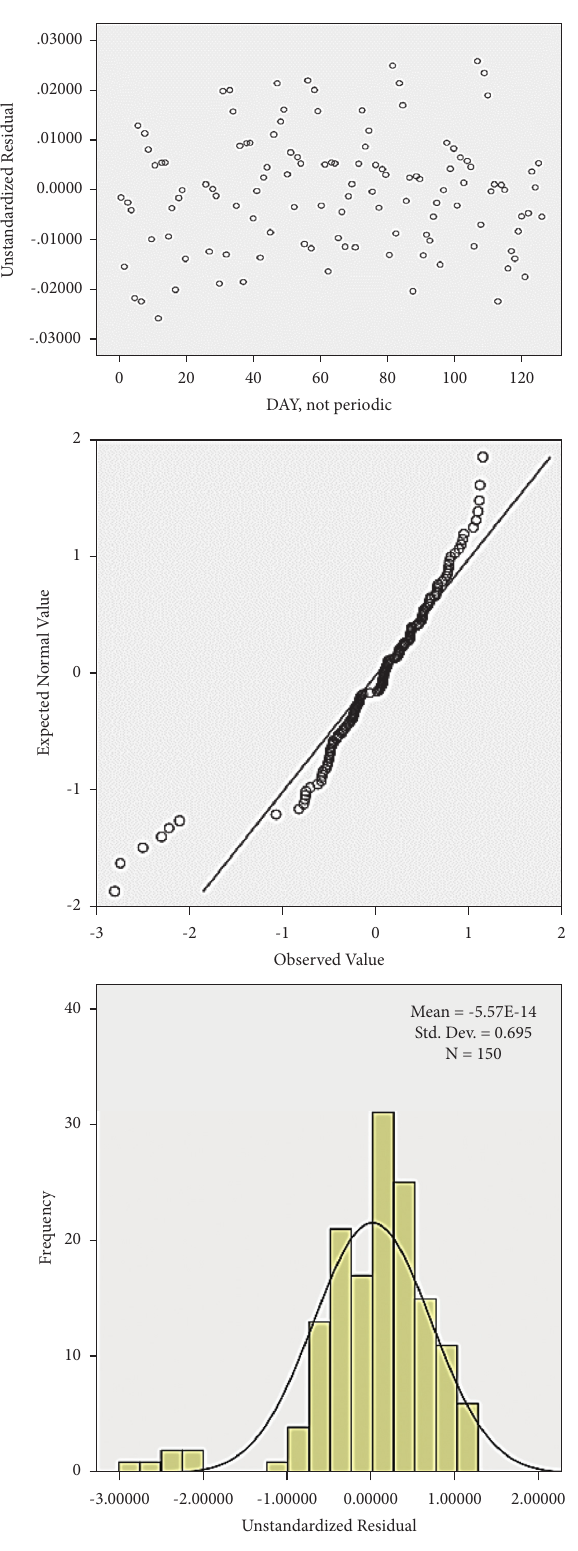
Figure 25: Histogram, quadratic diagram, and variance diagram of slip angle model in the horizontal arc for the